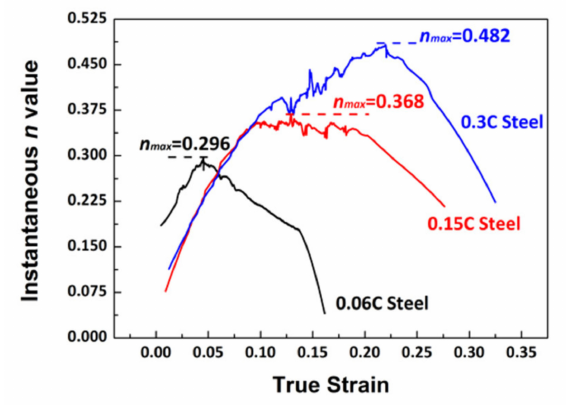
Figure 6. Work hardening behavior of the experimental